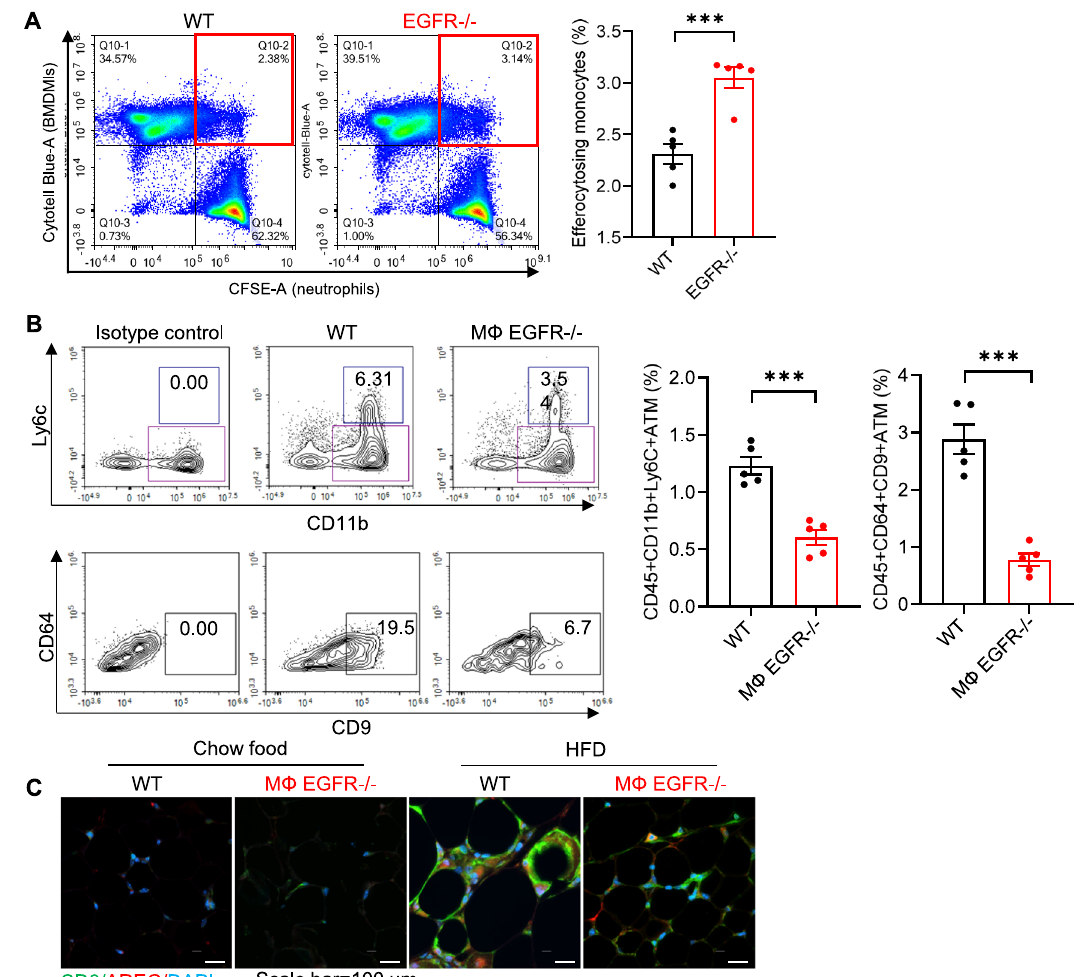
Fig. 7 | Myeloid EGFR − / − mice had decreased subpopulations of ATMs in diet- induced obesity. A An efferocytosis assay was performed by ex vivo co-culturing BMDMs (labeled with Cytotell Blue) isolated from WT and myeloid EGFR − / − mice with neutrophils isolated from WT mice that were treated with Staurosporine to induce apoptosis and labeled with CFSE. The fi rst quadrant (in red) represents the